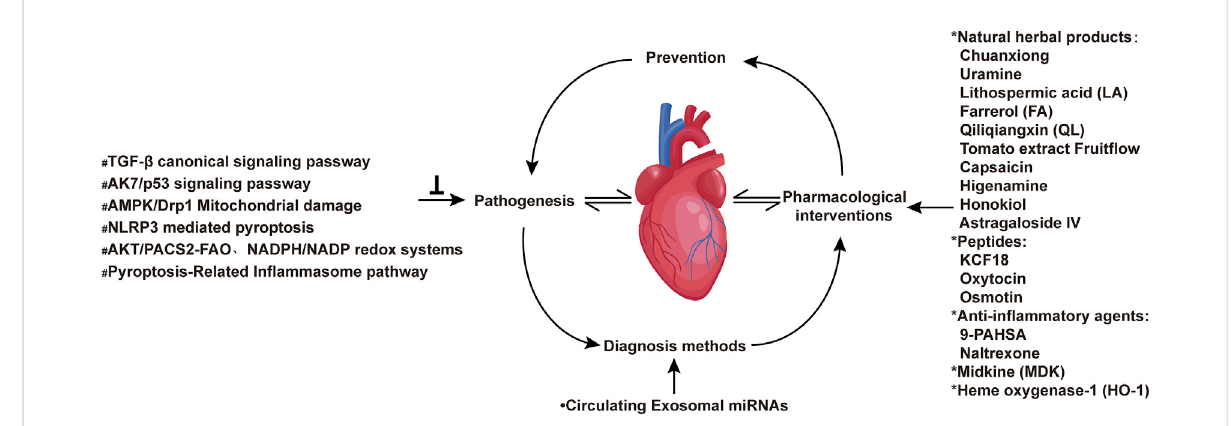
FIGURE 1 In fl ammatory signaling pathways and pharmacological interventions in cardiovascular diseases. * Different types of drugs that interfere with cardiovascular in fl ammation covered in the research theme; mechanisms involved in chronic in fl ammation in cardiovascular